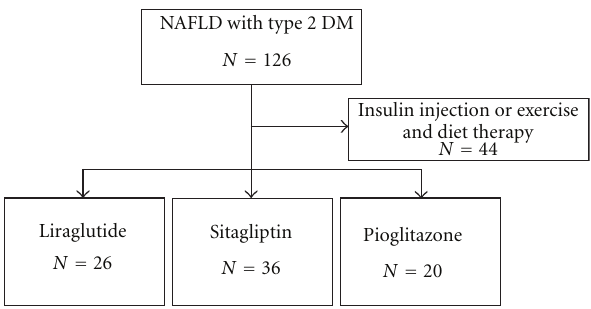
Figure 1: A total of 126 patients who were clinically diagnosed NAFLD with type 2 DM visited the outpatient clinic of Department of Diabetes and Metabolism or Department of Gastroenterology, Mitsui Memorial Hospital. We retrospectively analyzed 82 of them, excluding 44 patients only treated with insulin injection or exercise and diet therapy. We divided the rest 82 patients into three groups: liraglutide-treated group ( N = 26), sitagliptin-treated group ( N = 36), and pioglitazone-treated group ( N =